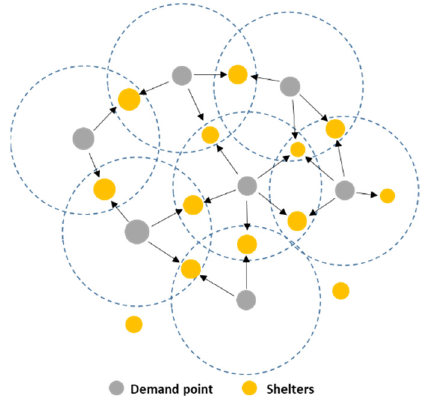
Figure 5. The circular evacuation allocation rules from demand points to shelters.